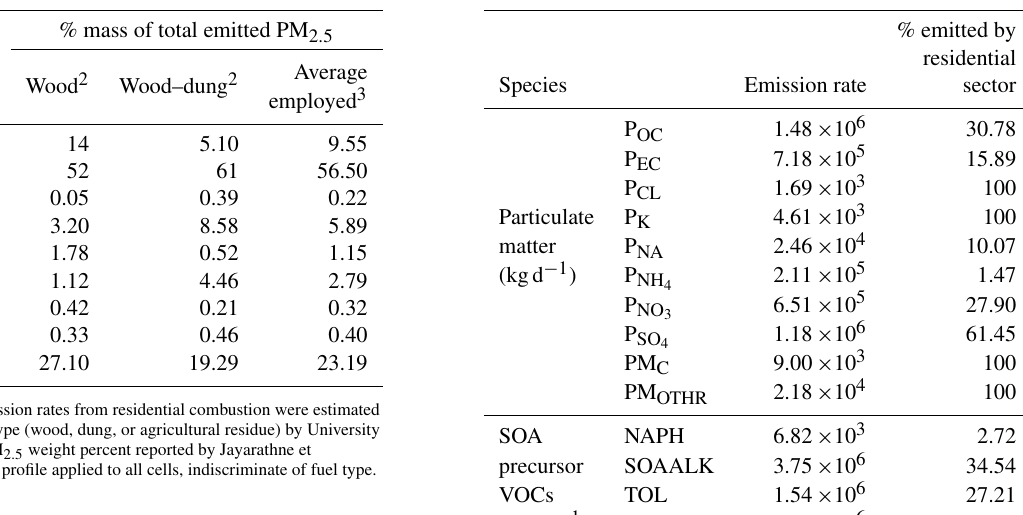
Table 3. PM 2 . 5 speciation by fuel type. Table 4. Particulate matter surface emissions over study